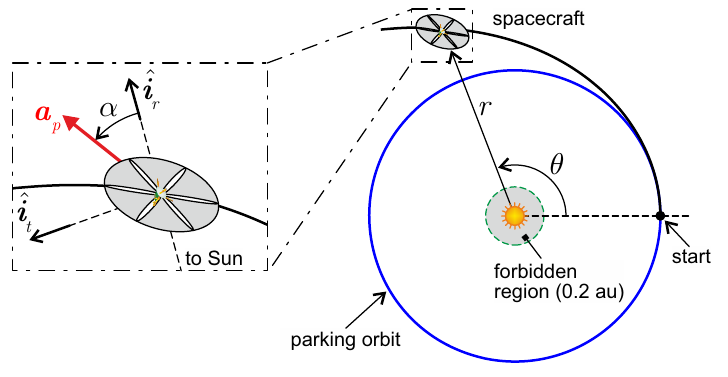
Figure 5. Reference frame and unit